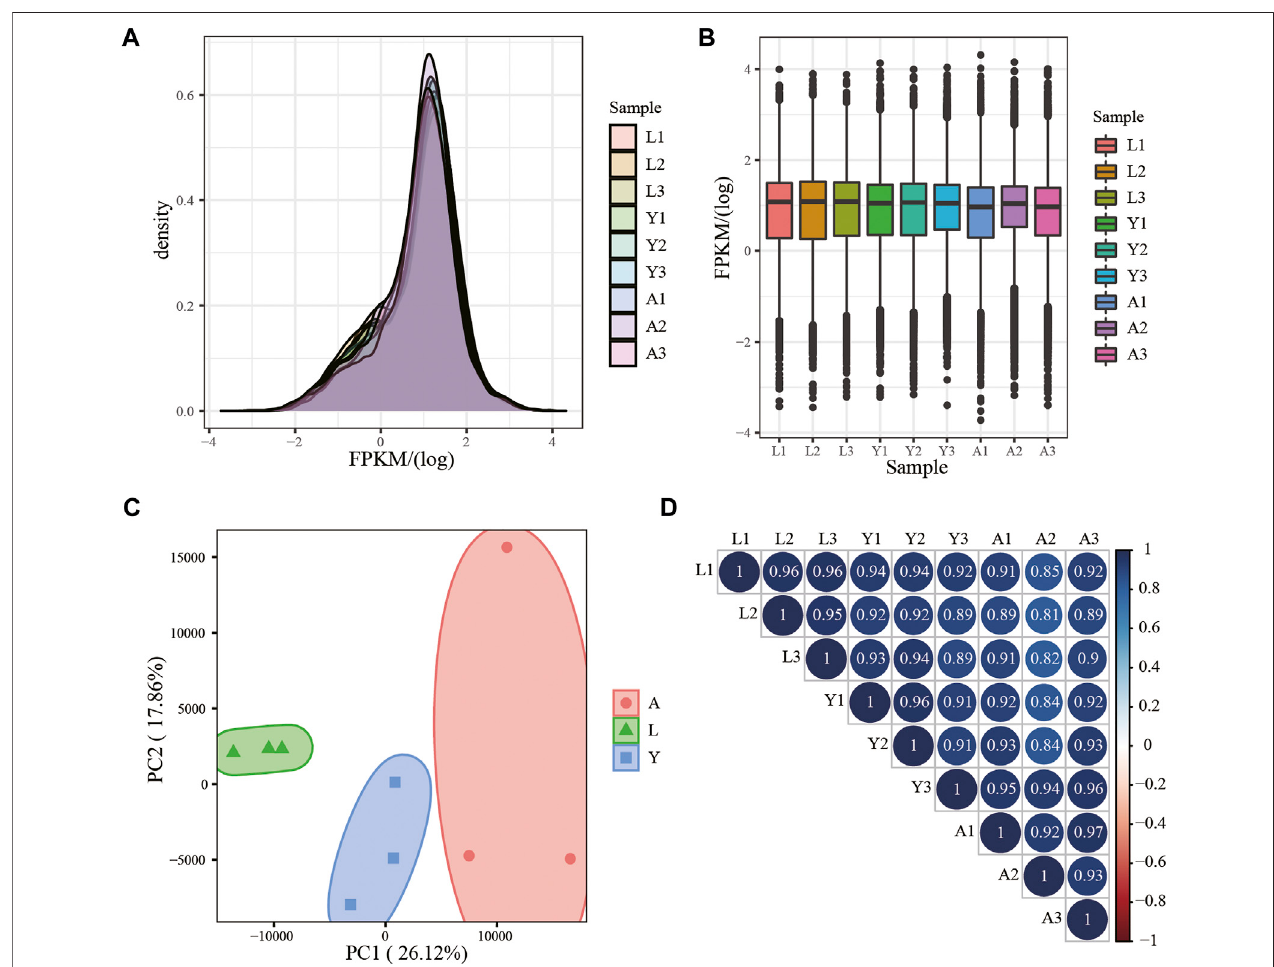
FIGURE2| mRNAexpressionanalysis. (A) DensitydistributionofmRNAswasaccordingtolog10(FPKM); (B) Ninesampleexpression (L1,L2,L3,Y1,Y2,Y3,A1, A2, and A3) violin plot, which was replaced by log10 (FPKM). (C) PCA distribution of nine samples; (D) Sample relationship cluster analysis.